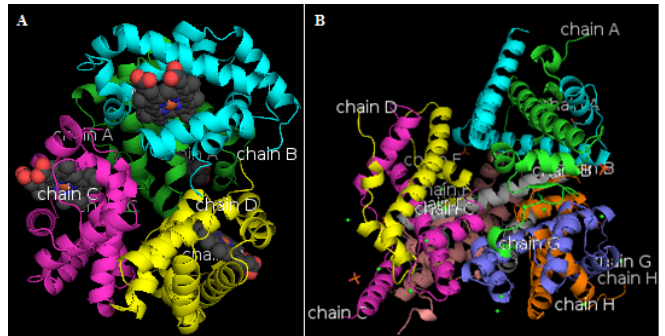
Figure 6. Structures of hemoglobin subunit alpha-A and ATP synthase subunit beta. ( A ) hemoglobin subunit alpha-A; ( B ) ATP synthase subunit beta. The phosphorylation site, pI, GRAVY, and abundance of phosphorylated proteins in serine, tyrosine, and lysine of goose liver proteins. Phosphorylated proteins were upreg- ulated or downregulated due to double pH-shifting treatment and protein phosphoryla- tion. Glyceraldehyde-3-phosphate dehydrogenase, glutathione S-transferase, and A8RRQ6 (isocitrate dehydrogenase) were highly enriched in each group, suggesting that these proteins had high emulsifying capacities. The pH-shifting treatment led to a de- crease in the abundances of glyceraldehyde-3-phosphate dehydrogenase, glutathione S- transferase, isocitrate dehydrogenase, R0JSM9 (heat shock protein HSP 90-alpha), R0LAD1 (ribosomal protein), R0LCM7 (sulfotransferase), U3IQ39 (heterogeneous nuclear ribonucleoprotein A3), and A0A068C605 (elongation of very long chain fatty acid protein 5), especially U3IW62 (RNA helicase). pH shifting changed the secondary structures and the exposure of protein hydrophobic groups, leading to the adsorption of proteins onto the oil–water interfacial layer and the dispersion of oil droplets, consequently affecting the kinds and quantities of goose liver proteins involved in the emulsion layer. Moderate exposure of protein hydrophobic groups could promote the interaction of the protein mol- ecule and the oil molecule to facilitate more proteins to coat on the surfaces of oil mole- cules, consequently leading to a decrease in the oil–water interfacial tension, together with the enhancement of the emulsifying stability [57]. This finding explained why the pH shifting treatment also resulted in an increase in the abundances of isocitrate dehydrogen- ase, R0LFA3 (coatomer subunit beta), and U3IFD3 (myosin heavy chain 11). Protein phos- phorylation increased the abundances of glyceraldehyde-3-phosphate dehydrogenase,